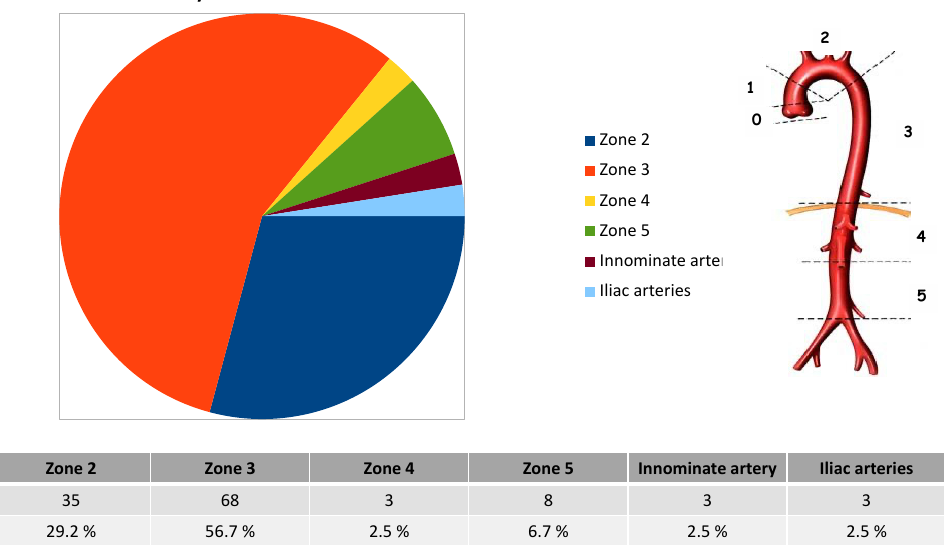
Figure 2. Location of the aneurysmal evolution on the distal aorta.